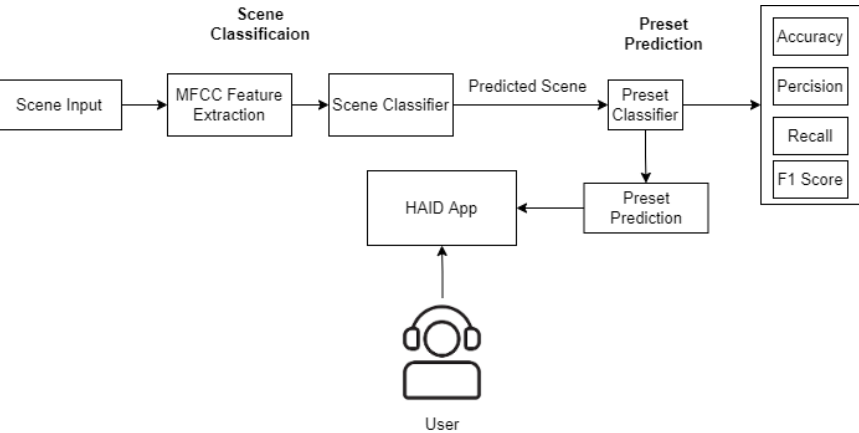
Figure 8. User preference selection.